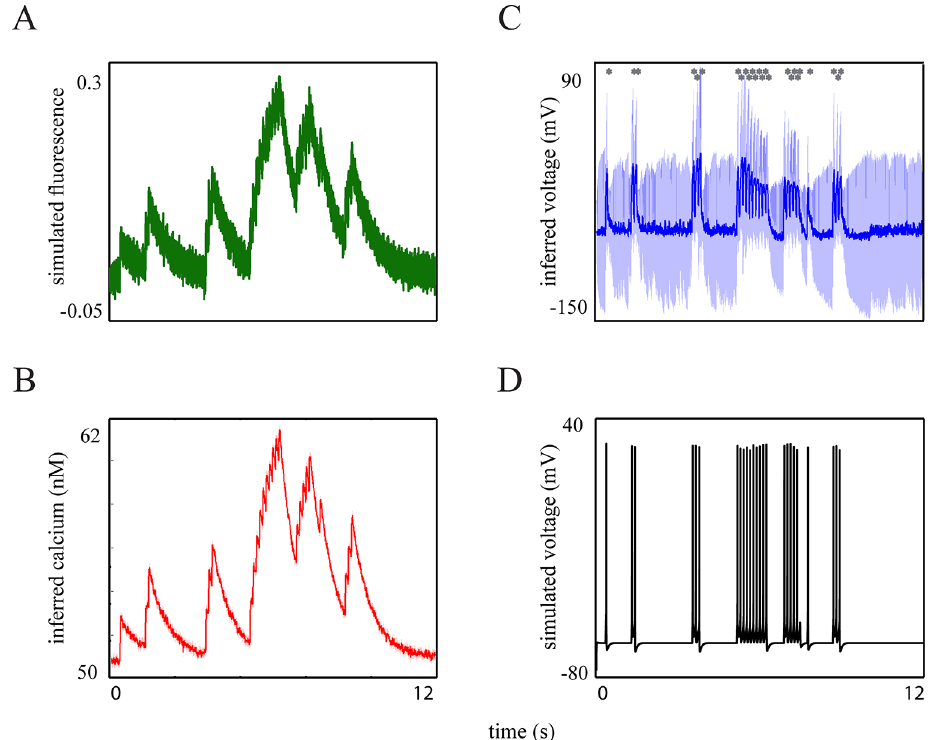
Fig 6. Results of the proposed approach for synthetic burst-evoked transients with fast rise times. ( A ): The fluorescence trace generated by the bursting-QGIF model, sampled at a high frequency of 700 Hz . ( B ): Inferred non-saturating [Ca 2+ ] kinetics. ( C ): Inferred membrane potential, ( D ): Simulated membrane potential of the bursting-QGIF model. Comparison of C and D indicates that both single and within-burst spikes could accurately be detected (note also the grey stars), resulting in a precise estimation of the interburst intervals and periods of quiescence. The values of parameters for the simulations and inversions, as well as the prior distributions can be found in Tables 1 and